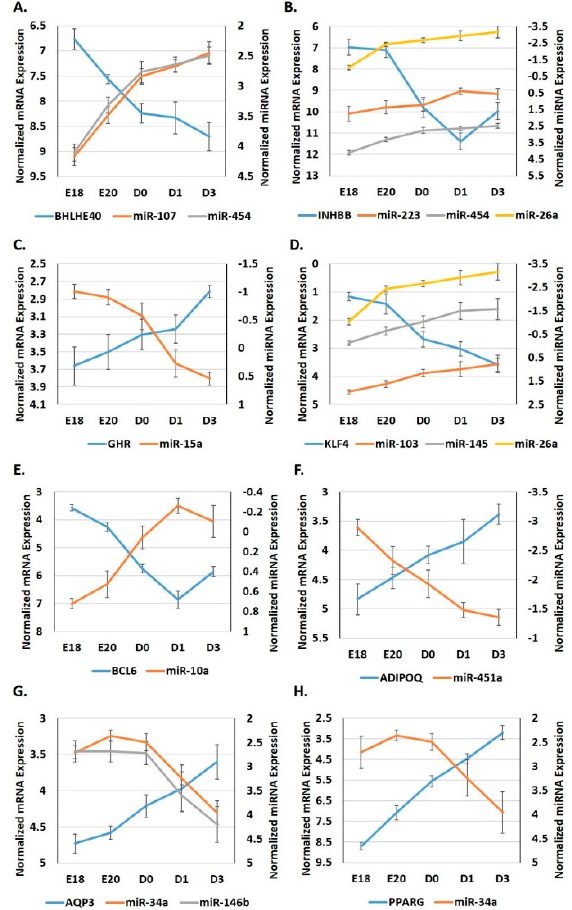
Figure 3. RT-qPCR adipocytic expression profiling of selected miRNAs and their target genes in Ross 708 broilers. The expression signatures of miRNA/target pairings of interest, identified in the NGS study, were determined in the adipose tissue of Ross 708 broilers using RT-qPCR. ( A ) Expression of BHLH40 and its targeting miRNAs, miR-107 and miR-454 . ( B ) Expression of INHBB and its targeting miRNAs, miR-223 , miR-454 , and miR-26a . ( C ) Expression of GHR and its targeting miRNA, miR-15a . ( D ) Expression of KLF4 and its targeting miRNAs, miR-103 , miR-145 , and miR-26a . ( E ) Expression of BCL6 and its targeting miRNA, miR-10a . ( F ) Expression of ADIPOQ and its targeting miRNA, miR-451a . ( G ) Expression of AQP3 and its targeting miRNAs, miR-34a and miR-146b . ( H ) Expression of PPARG and its targeting miRNA, miR-34a . Data are presented as normalized expression values ( Δ Ct).